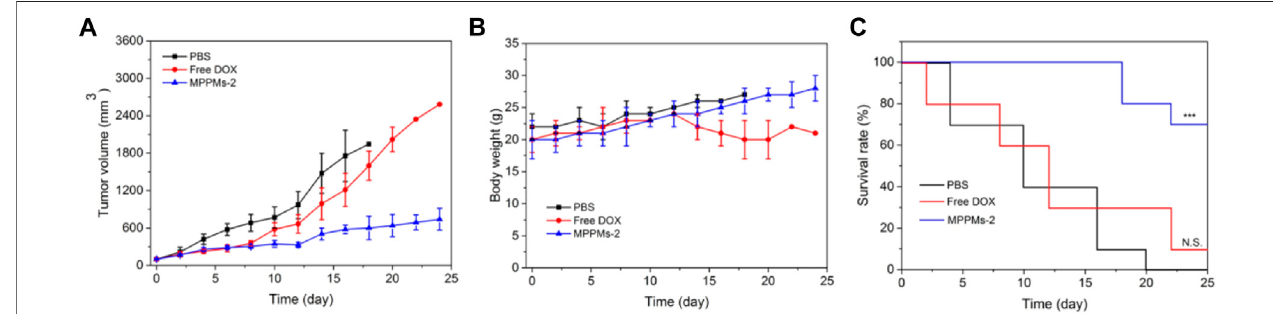
FIGURE 8 | (A) Tumor volume of tumor-bearing mice after different PBS, free DOX, and MPPMs-2 treatments. (B) The body weight of tumor-bearing mice after different PBS, free DOX, and MPPMs-2 treatments ( n = 10, mean ± SD). (C) Survival rates of tumor-bearing mice after different PBS, free DOX, and MPPMs-2 treatments. Statistical analysis was done using Kaplan – Meier method ( n = 10). p values: * p < 0.05, ** p < 0.01, *** p < 0.001; N.S., no signi fi